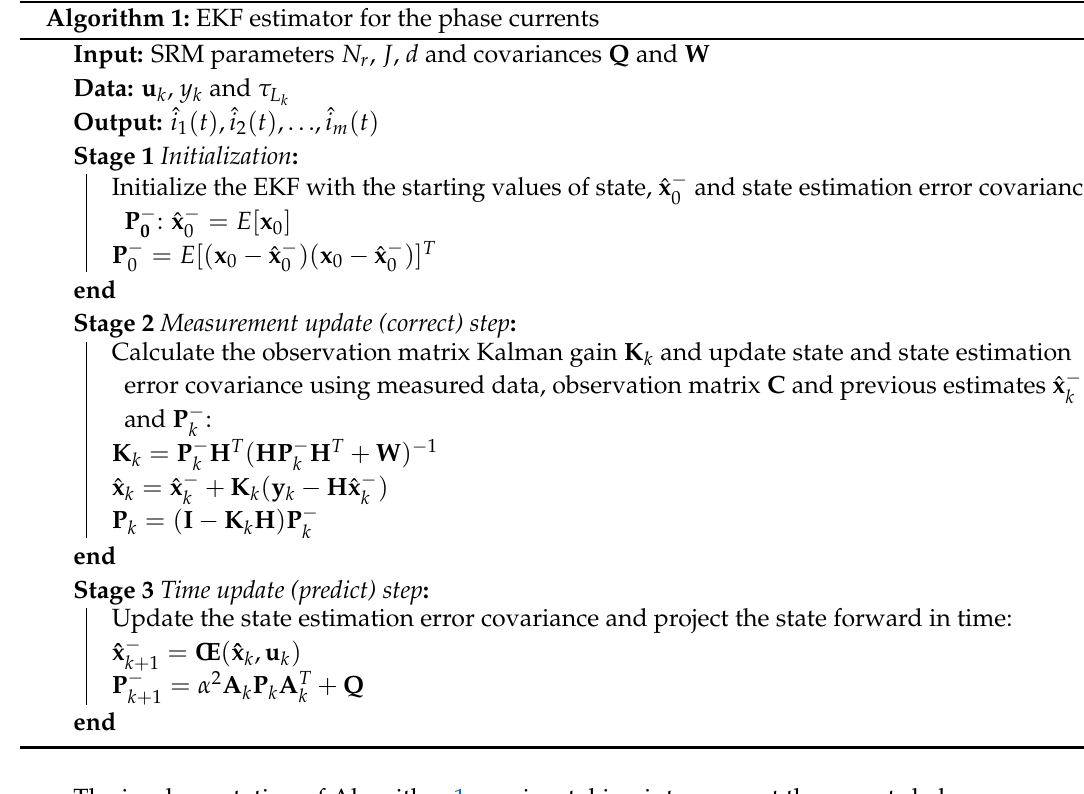
Algorithm 1: EKF estimator for the phase